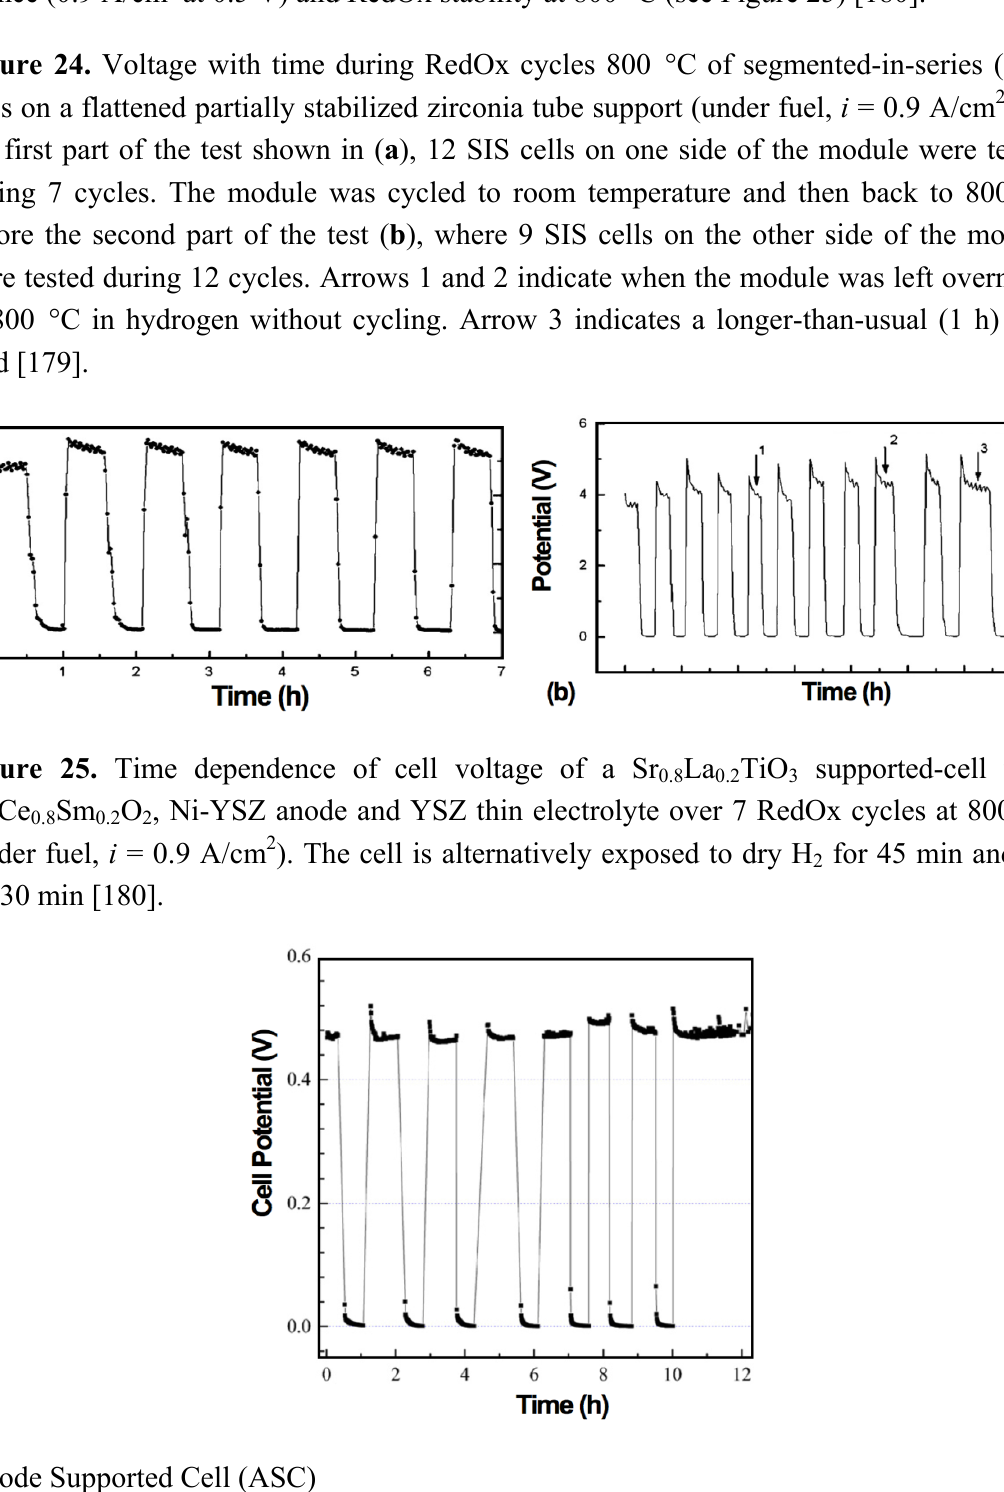
Figure 24. Voltage with time during RedOx cycles 800 °C of segmented-in-series (SIS) cells on a flattened partially stabilized zirconia tube support (under fuel, i = 0.9 A/cm 2 ). In